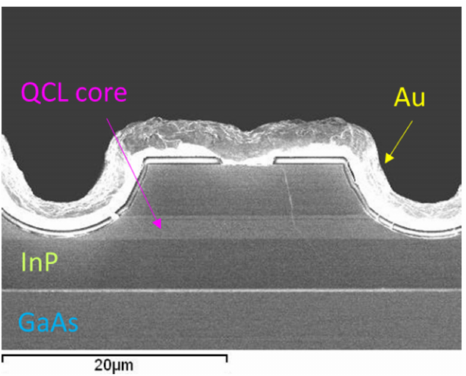
Figure 1. SEM cross-section of InP-based QCL grown on GaAs substrate.